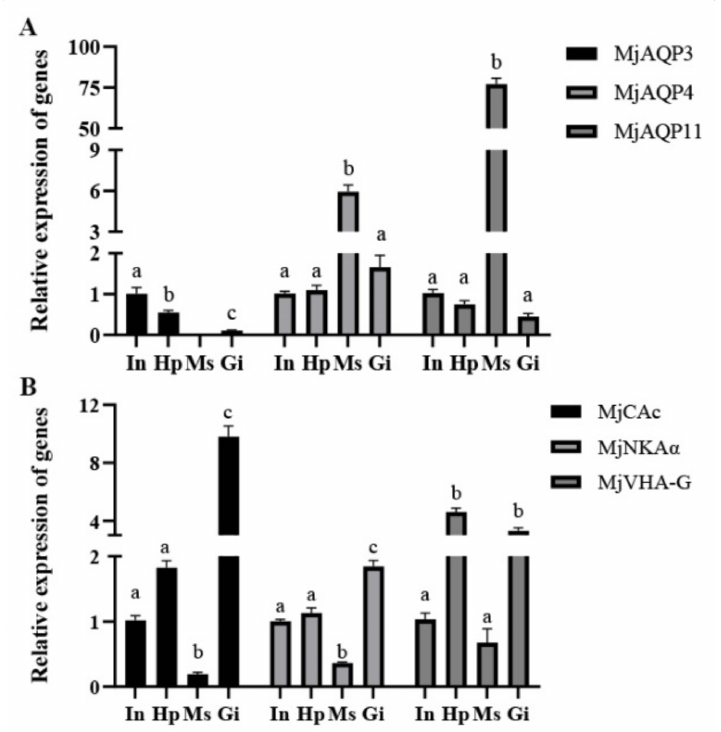
Figure 2. The relative expression levels of ( A ) MjAQPs and ( B ) MjCAc , MjNKA α , and MjVHA-G in different tissues of M. japonicus . Abbreviations: In, intestine; Hp, hepatopancreas; Ms, muscle; Gi, gill. The relative expression level of each gene in the intestine is separately used as calibrator. The data are presented as mean + SD ( n = 3). Means labeled with different letters are significantly different ( p < 0.05, one-way ANOVA,